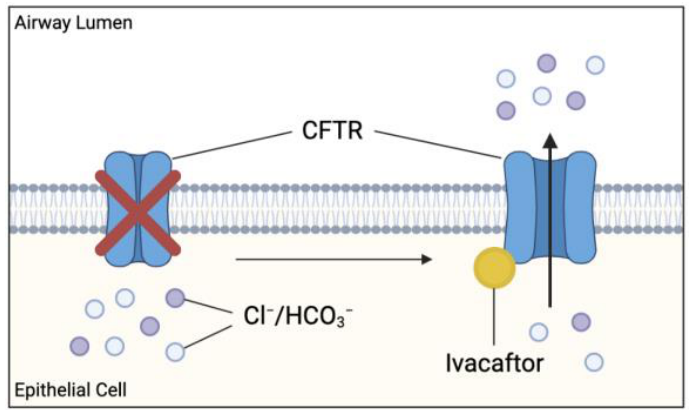
Figure 7. Effect of cystic fibrosis transmembrane conductance regulator (CFTR) potentiator ivacaftor on dysfunctional CFTR. Ivacaftor binds directly to CFTR protein, increasing the time which activated CFTR channel remains open at the apical membranes. Results in increased chloride and bi- carbonate ion transport at these sites, possibly improving the clinical outcome in CF patients.